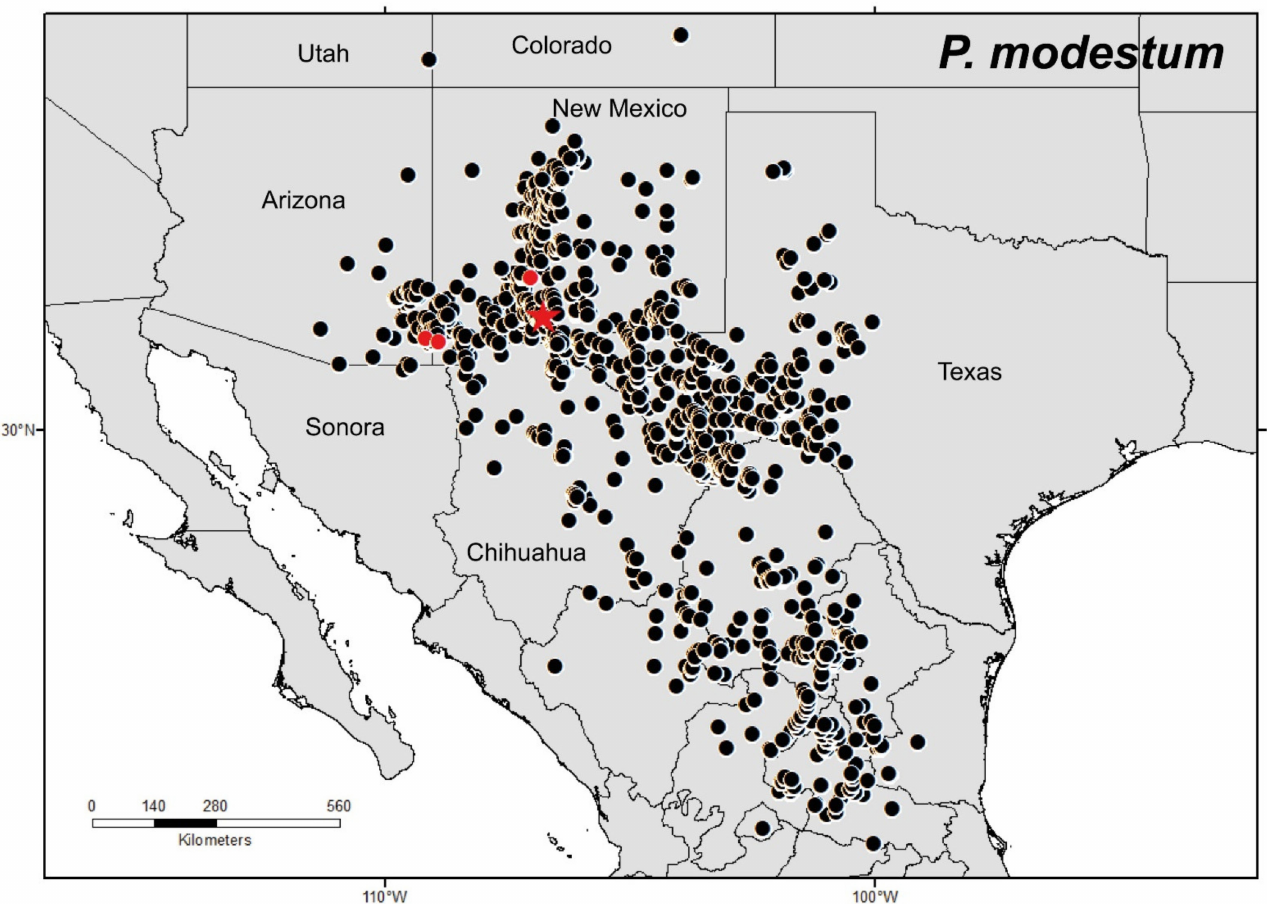
Figure 13. Map showing distributional records of Phrynosoma modestum . Red circles = genetically confirmed records; black circles = records that have not been genetically confirmed; red star = restricted type locality of P. modestum